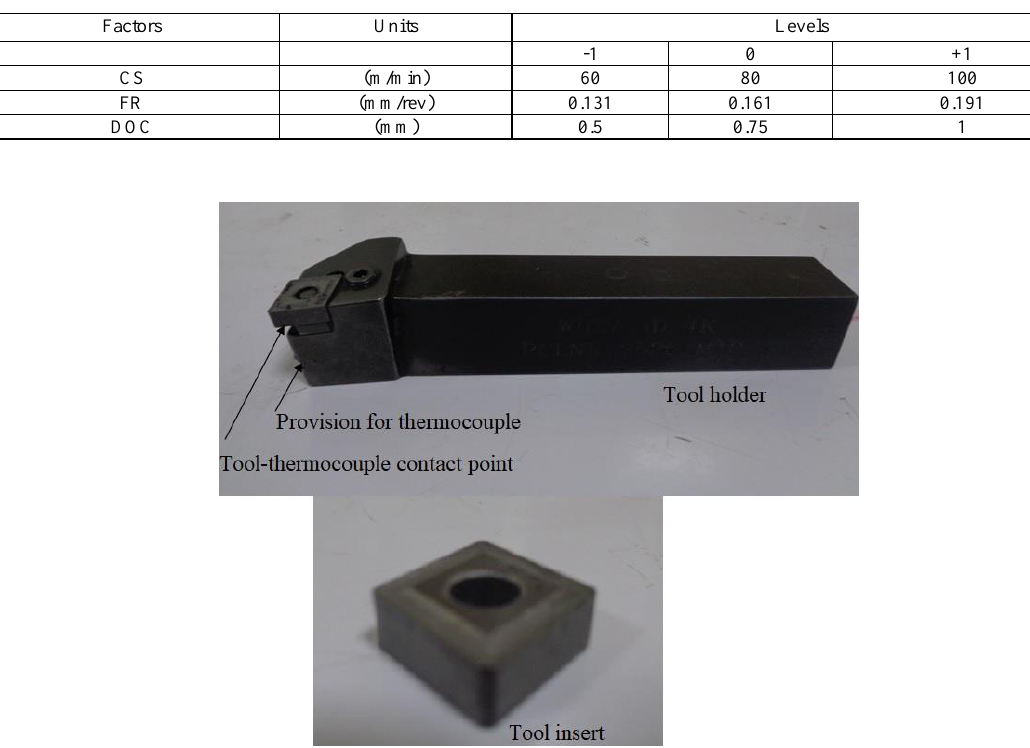
Figure 1. Cutting tool and tool holder